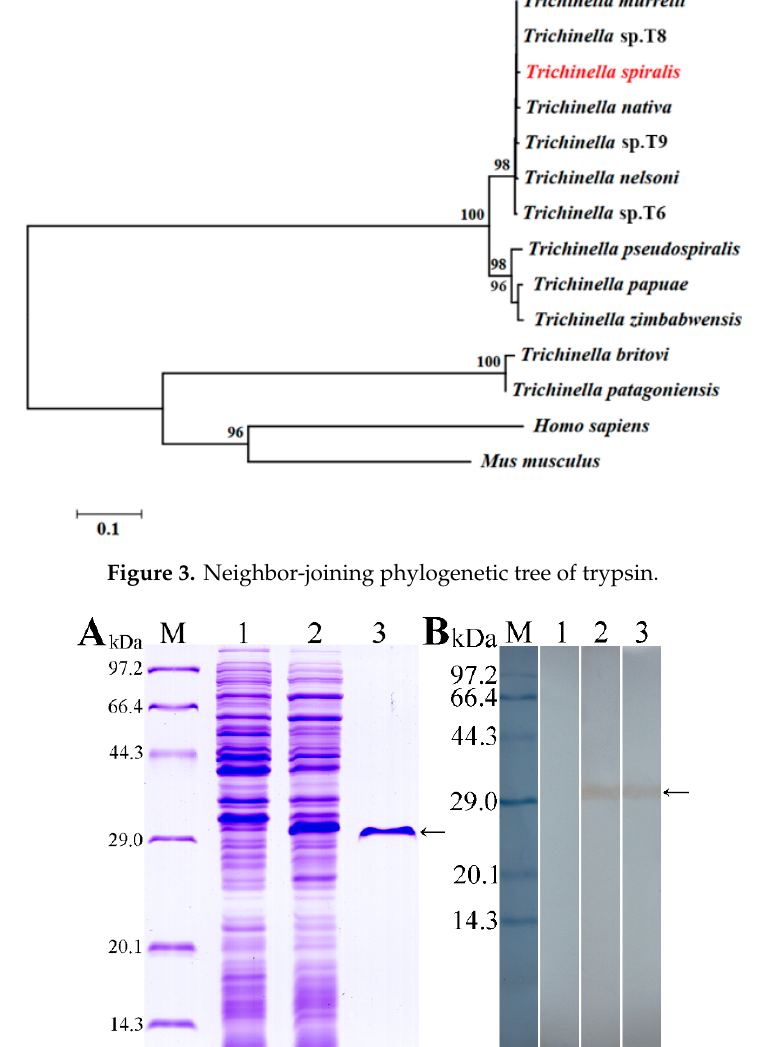
Figure 4. Expression and identification of recombinant TsT protein. ( A ): Expression and purification of rTsT. SDS-PAGE analysis showing rTsT was expressed in IPTG-induced E. coli lysates (lane 2), but not expressed in E. coli lysate prior to induction (lane 1). Lane 3: the purified rTsT protein. ( B ): Western blot analysis of the rTsT immunoreaction. Lane 1: un-induced E. coli lysate was not recognized by anti-his McAb. Specific recognition of expressed rTsT in induced E. coli lysate (Lane 2) and purified rTsT by anti-his McAb. Arrow shows the rTsT.